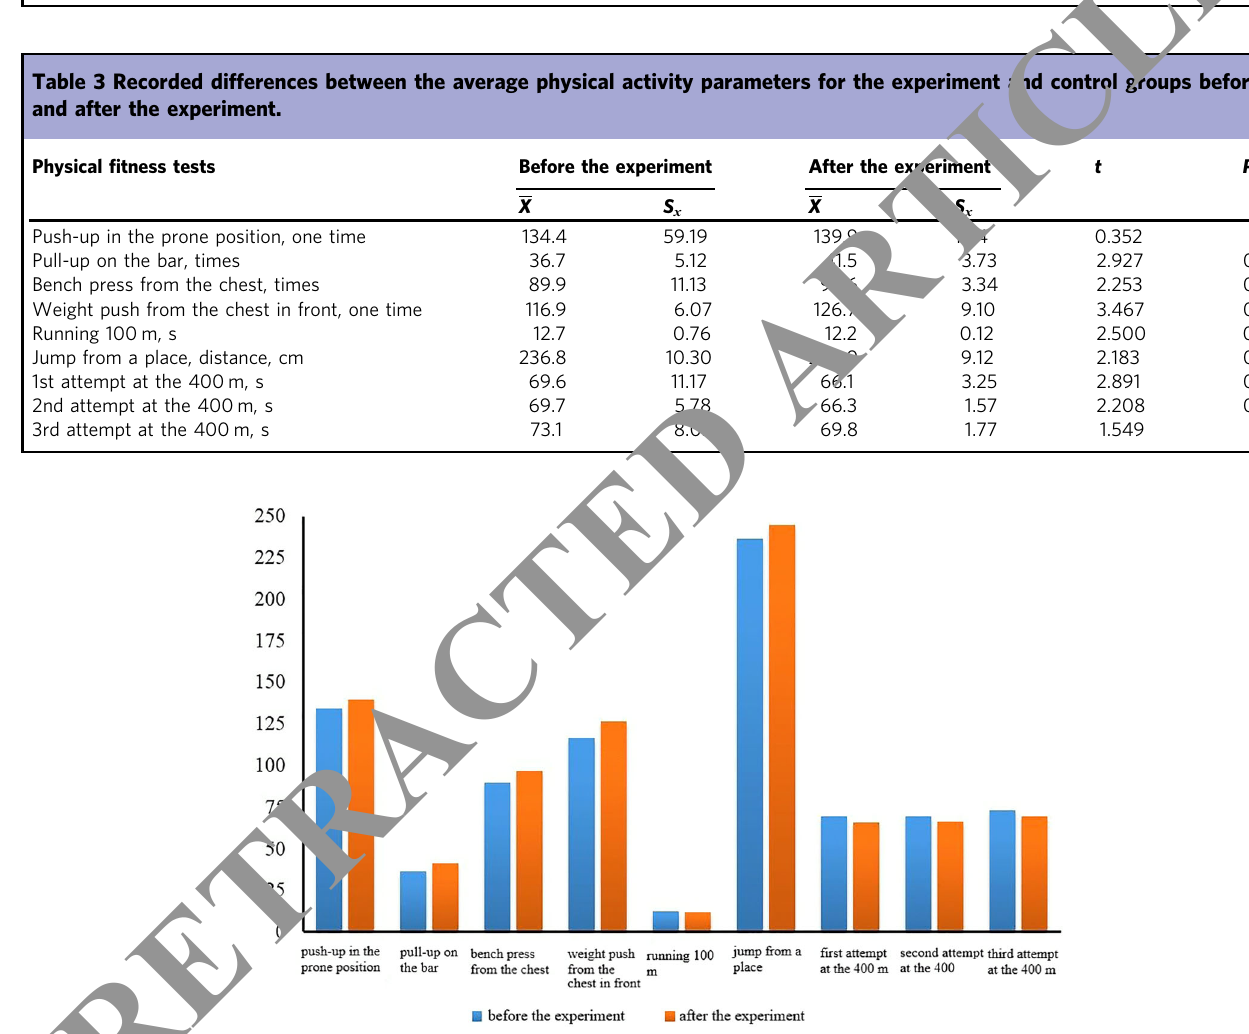
Fig. 1 Parameters of physical activity in the experimental and control groups for professional boxers at the beginning of the experiment. Changes in the physical fi tness parameters in the experimental group, at the initial and fi nal stages of the